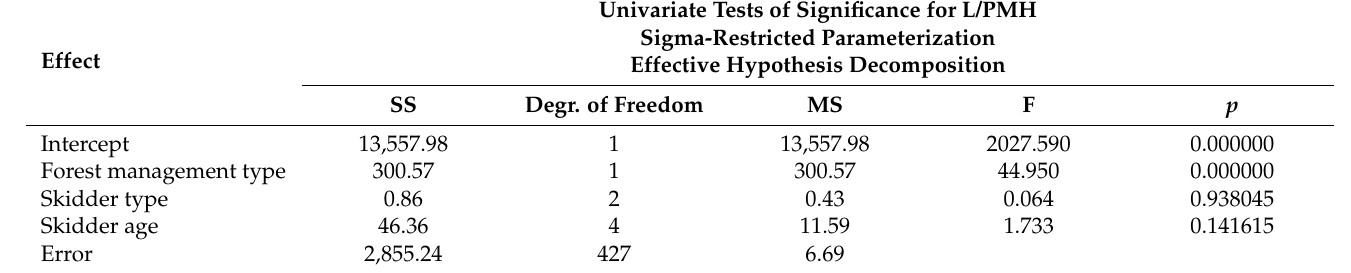
Table 4. Results of univariate test of significance for fuel consumption with the method, skidder type, and skidder age as independent variables